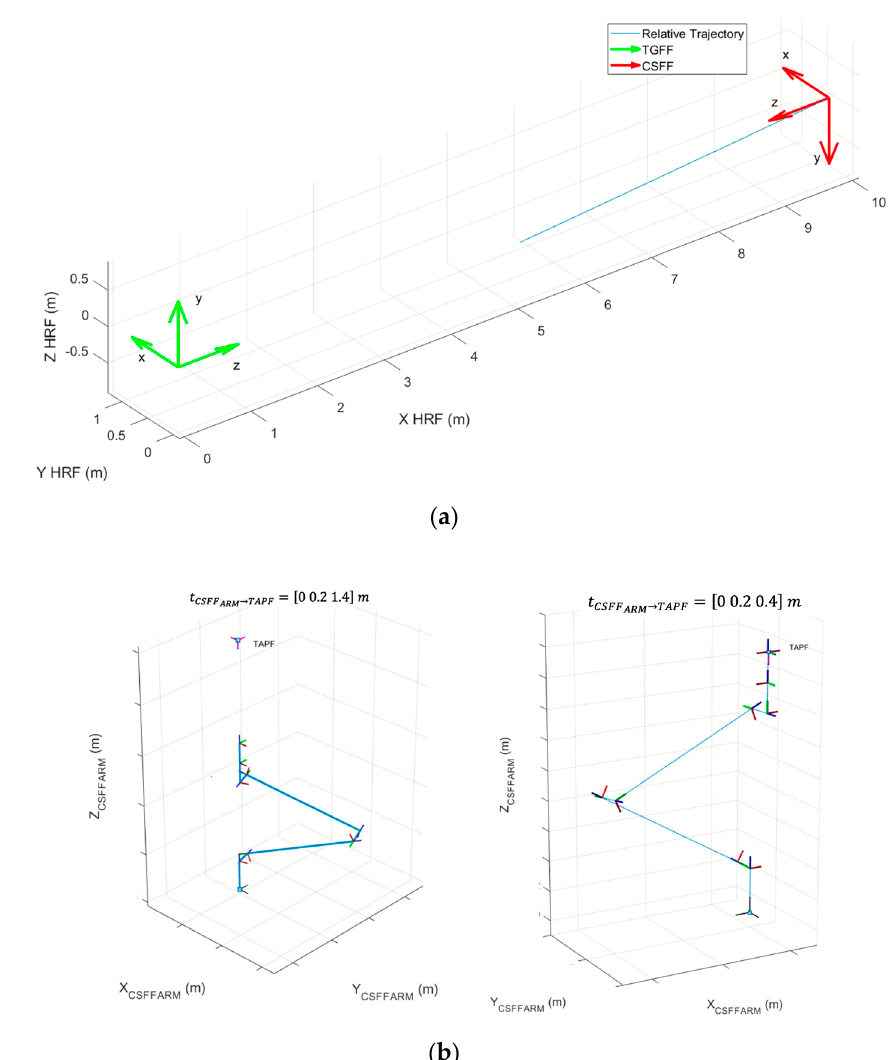
Figure 12. Relative trajectories employed in the simulations: ( a ) relative trajectory of the chaser to- ward the target and the corresponding body-fixed reference frames at scenario start; ( b ) schematic representation showing the end-effector/grasping point pose corresponding to set-points 2 and 3.